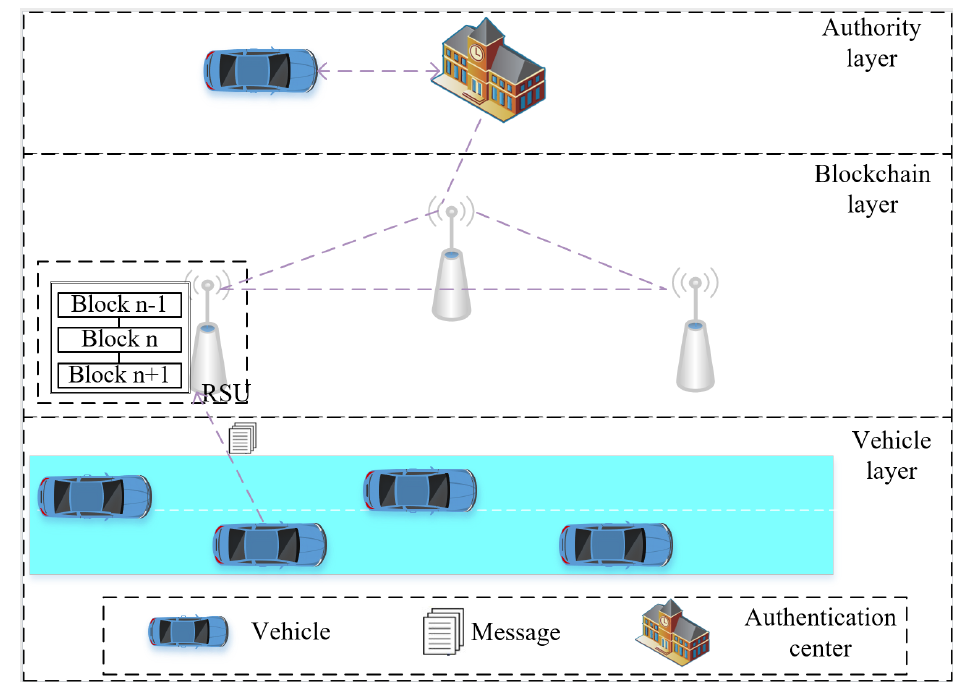
Figure 1. Schematic diagram of vehicle pre-authentication and handover architecture.